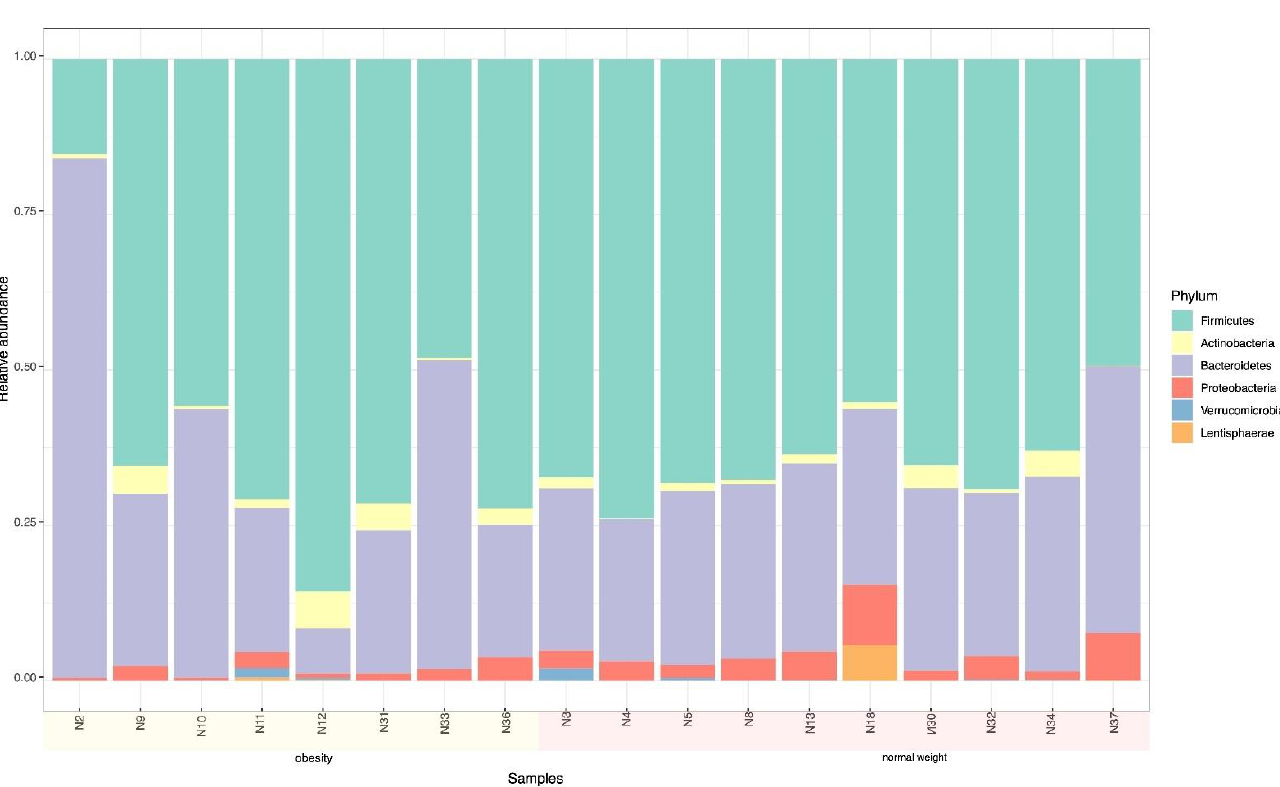
Figure 1. Relative abundance by phylum in adolescent fecal samples. Firmicutes was the most abun- dant phylum followed by Bacteroidetes, Actinobacteria, Proteobacteria and Verrucomicrobia.